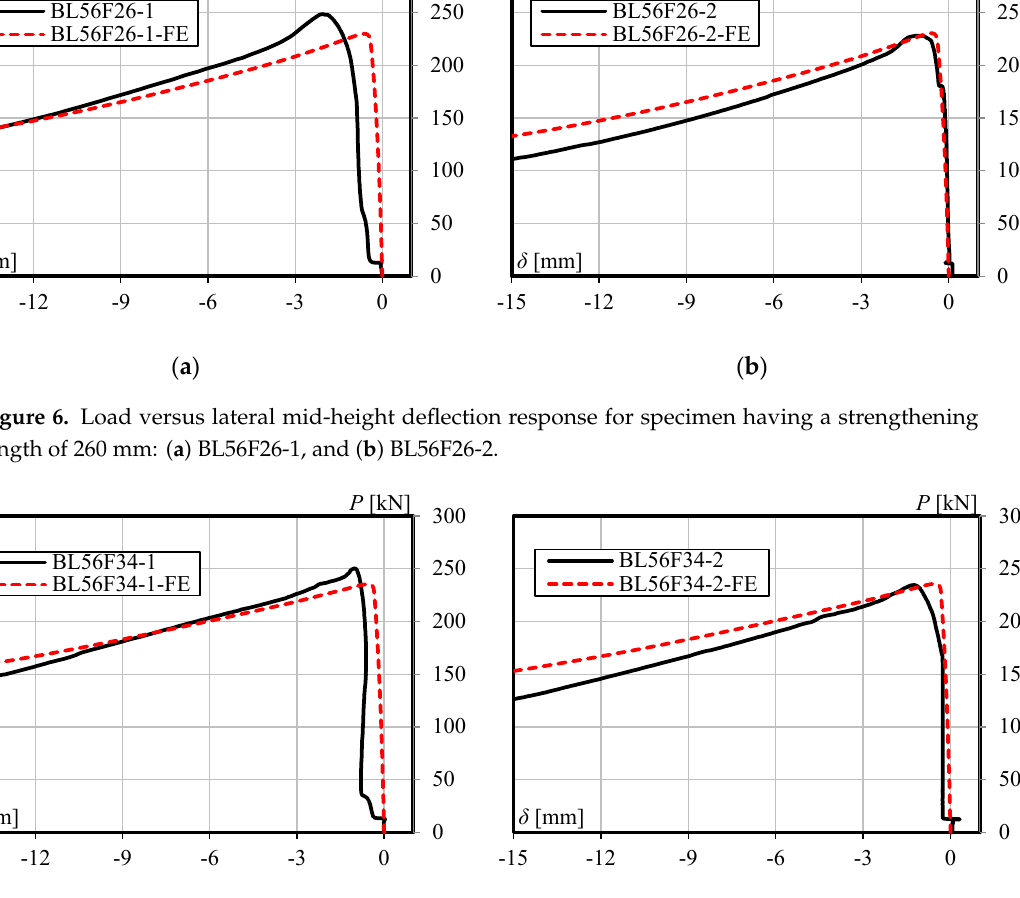
Figure 5. Load versus lateral mid-height deflection response for specimen NS56BL.